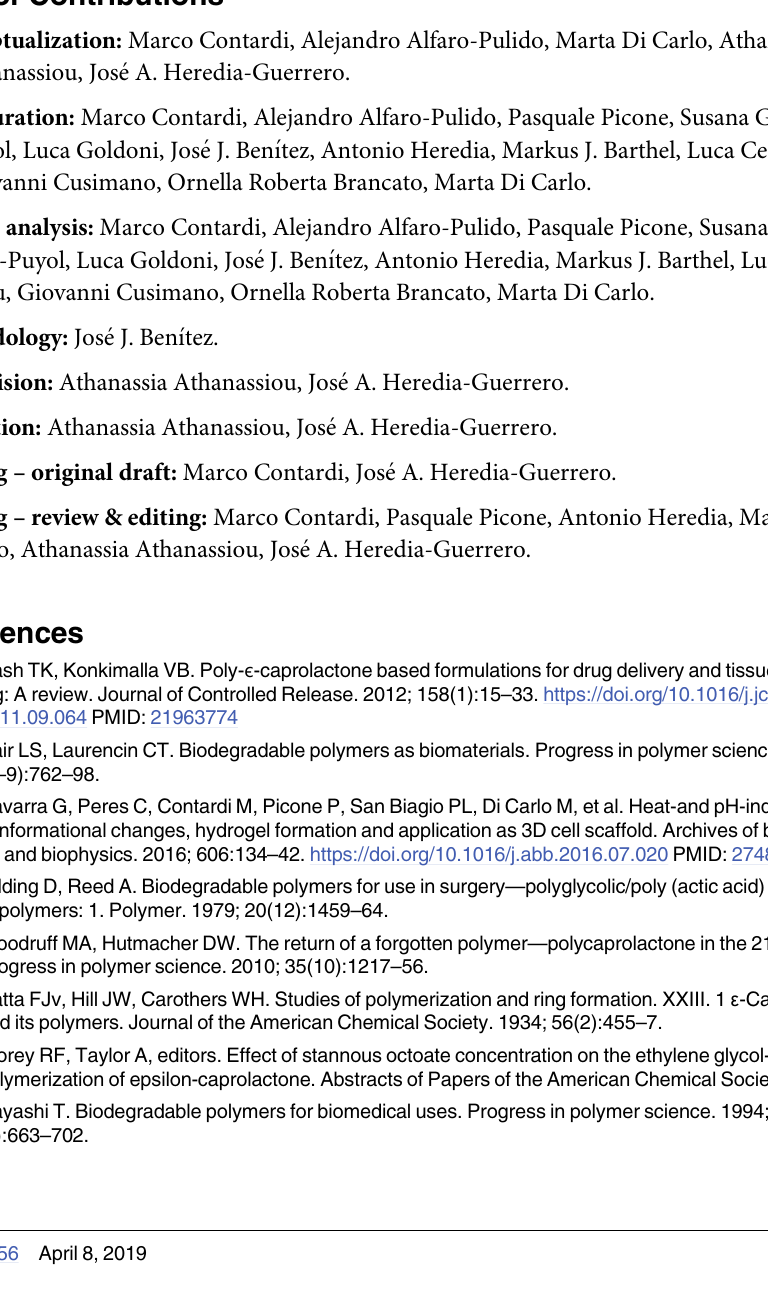
S1 Fig. 1D and 2D spectra of PCL. PLC in THF-d8 NMR spectra: a) 1H b) 1H-1H COSY